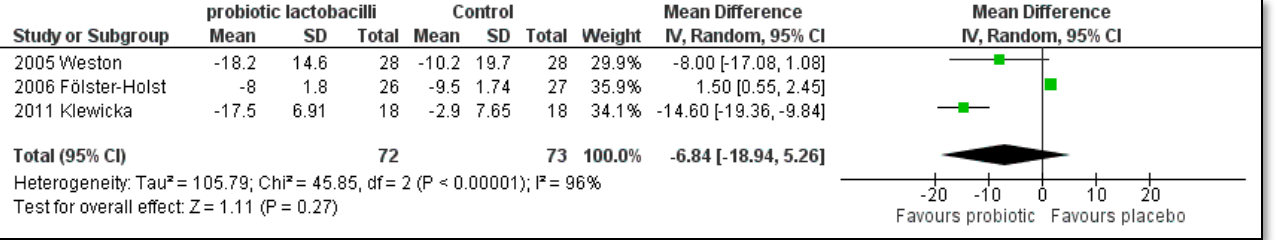
As shown in Figures 4 and 5, the sub-analysis regarding the treatment time of eight